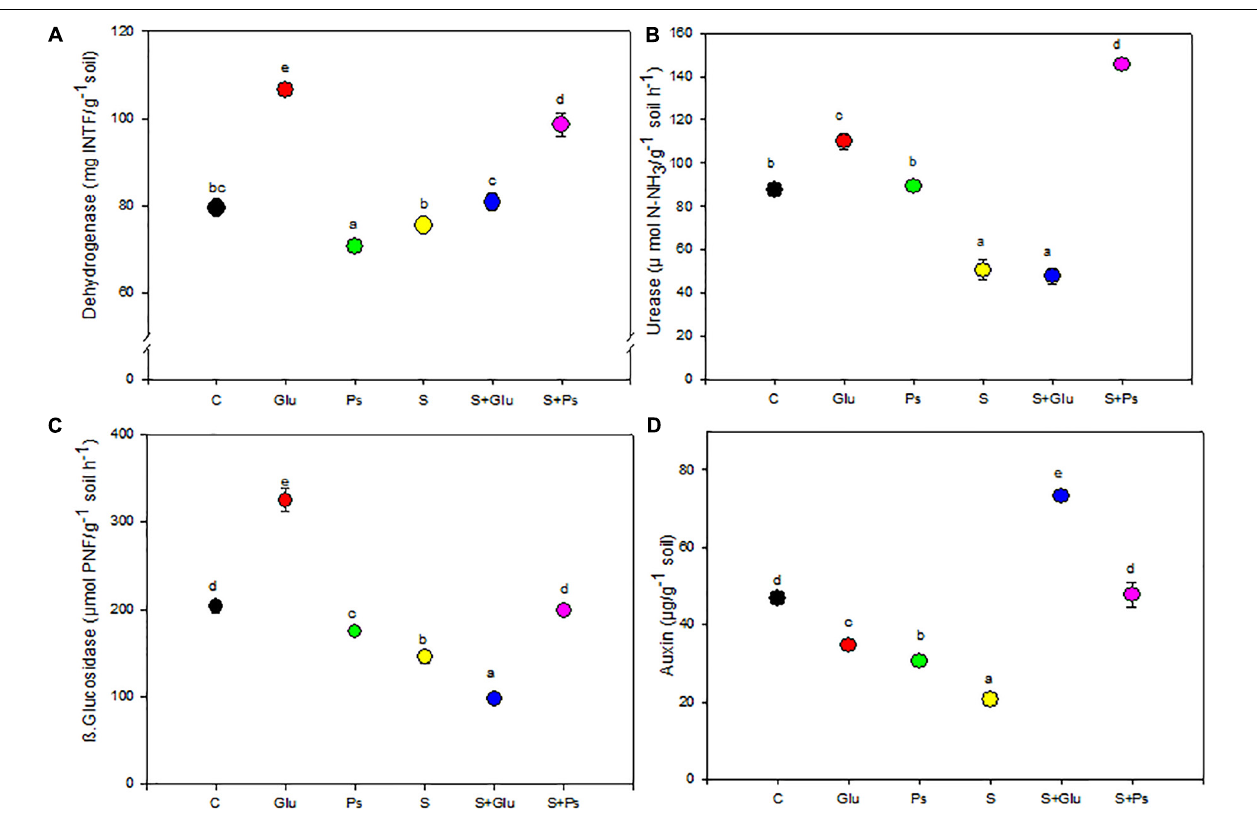
FIGURE 5 | Effect of bacterial inoculation on soil enzymatic activities (mU g − 1 of dry soil): (A) dehydrogenase, (B) urease, (C) β -glucosidase, and (D) IAA production of the rhizospheric soil of S. fruticosa plants, in the absence (0 mM NaCl) and in the presence of NaCl (600 mM NaCl). Values are the means standard deviation of five replicates. Values sharing the different letters indicate significant differences between treatments at the 5% level